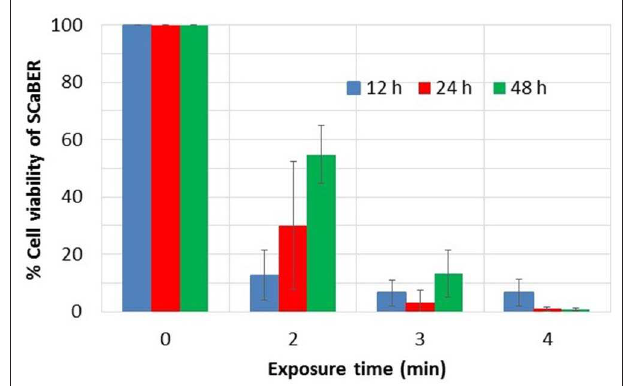
FIGURE 2 | Viability of SCaBER cells after PAM treatment, using MTS assay. Exposure time indicates the time the liquid media was exposed to plasma to make PAM. Measurements were made after 12, 24, and 48h of PAM application. Data is based on three independent experiments using two replications each. This figure is plotted based on data previously published in Mohades et al.